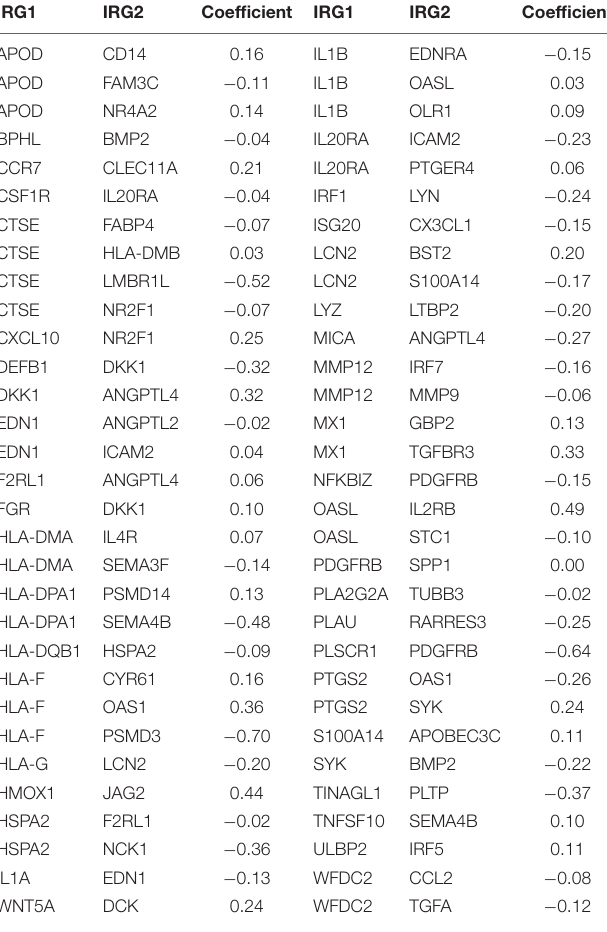
TABLE 1 | Information of prognostic